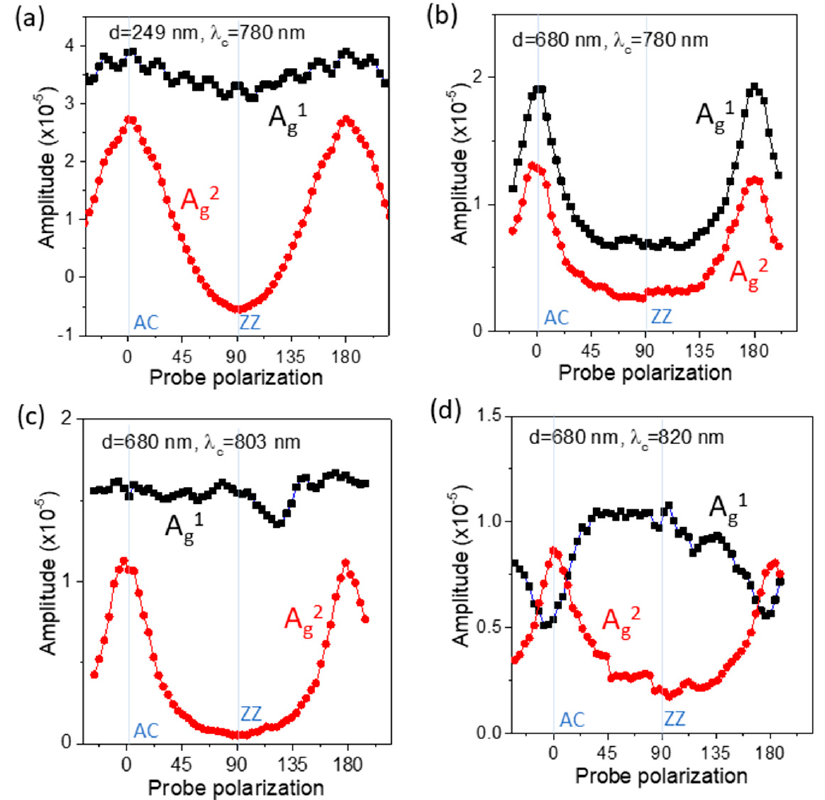
Figure 4. ( a , b ) Probe polarization dependence of the A g1 and A g2 mode CP amplitudes for BP flake thicknesses of 249 and 680 nm at a laser wavelength of 780 nm. ( c , d ) Those at laser wavelengths of 803 and 820 nm for the 680 nm thick BP flake.